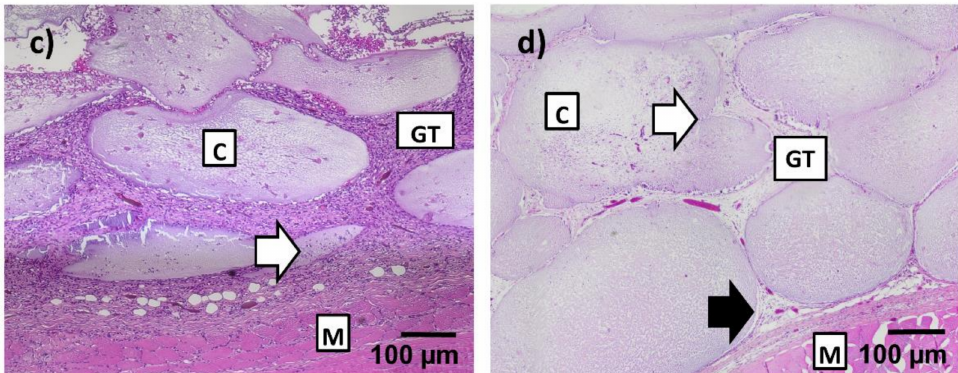
Figure 4. Macroscopic and microscopic (hematoxylin-eosin (H&E)-stained) appearance of constructs after explantation, representative images (not all groups are depicted, as no macroscopic difference was noticed between constructs with and without nBG). ( a ) macroscopic image, Group 1W_ADA-GEL-rMSC-nBG; loosely adhering, moist, transparent hydrogel beads; ( b ) macroscopic image, Group 4W_ADA-GEL-rMSC; firm, well adhering, opaque hydrogel beads; ( c ) H&E staining, 10 × , group 1W_ADA-GEL-rMSC; loose, highly cellular granulation tissue in the areas between beads, variable degree of infiltration with small cells (arrow); ( d ) H&E staining, 10 × , group 4W_ADA-GEL_rMSC; thin septae of connective tissue infiltrating the capsules (white arrow); a thin gap is visible between capsules and connective tissue (black arrow); GT = granulation tissue, C = capsules, M =